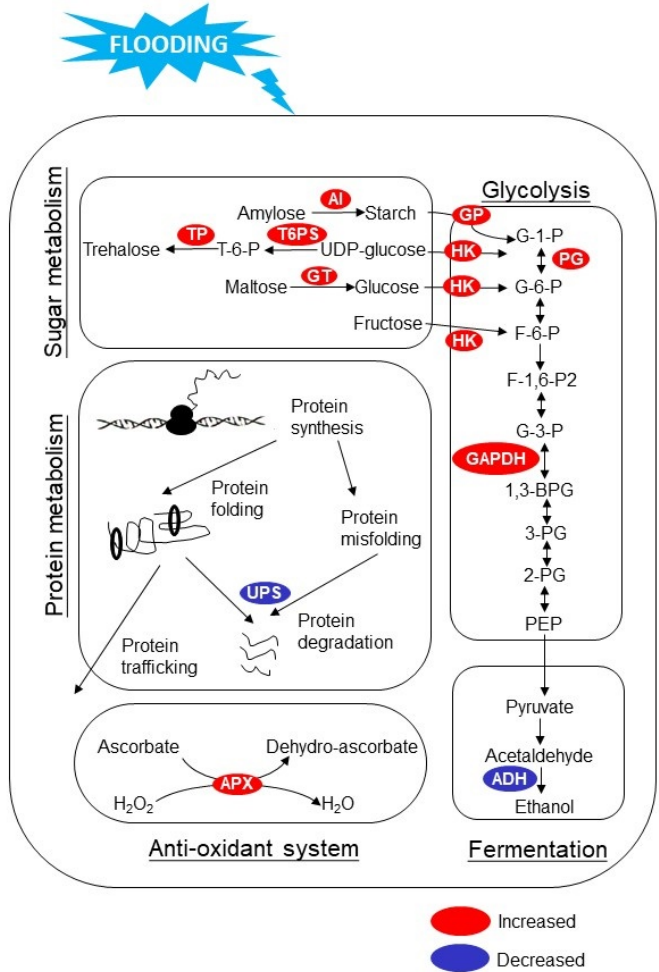
Figure 1. Altered proteins in millimeter-wave-irradiated plants compared to un-irradiated plants under flooding stress. The altered proteins according to previous studies were mapped onto a schematic diagram. Abbreviations are as follows: AI, amylose isomerase; TP, trehalose phosphatase; T6PS, trehalose 6-phosphate synthase; GT, glucanotransferase; GP, glycogen phosphorylase; HK, hexokinase; PG, phosphoglucomutase; GAPDH, glyceraldehyde-3-phosphate dehydrogenase; UPS, ubiquitin-proteasome system; APX, ascorbate peroxidase; ADH, alcohol dehydrogenase; T-6-P, trehalose-6-phosphate; G-1-P, glucose-1-phosphate; G-6-P, glucose-6-phosphate; F-6-P, fructose-6-phosphate; F-1,6-P2, fructose 1,6-bisphosphate; G-3-P, glyceraldehyde 3-phosphate; 1,3-BPG, glycerate 1,3-bisphosphate; 3-PG, 3-phospho-glycerate; 2-PG, 2-phospho-glycerate; PEP, phosphoenolpyruvate.